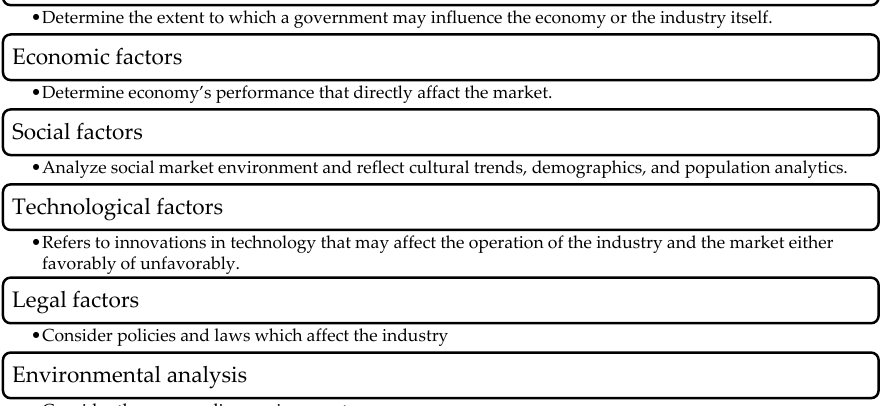
Figure 2. Framework of PESTLE analysis.